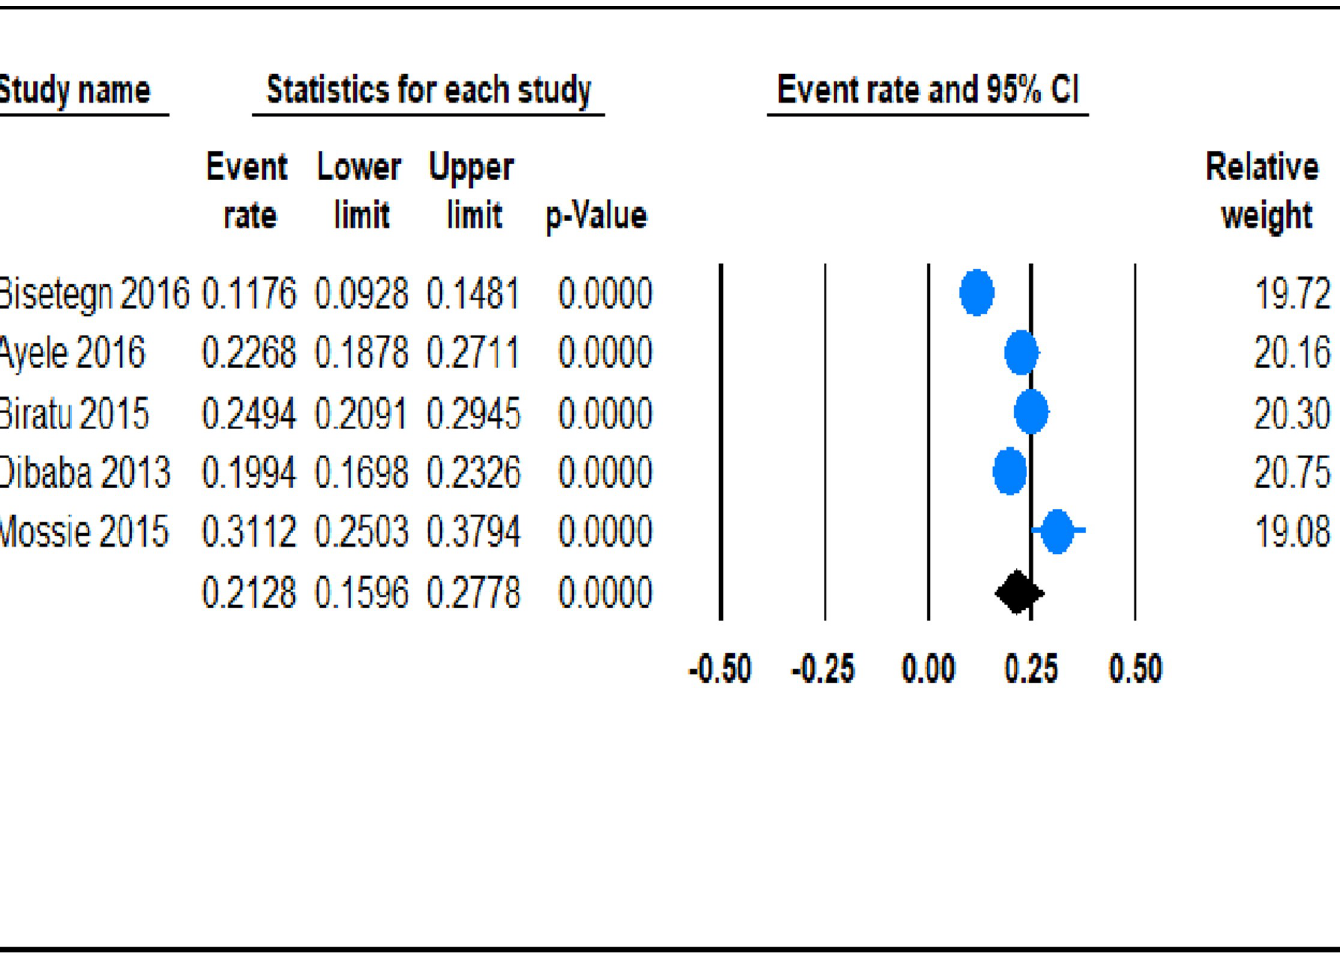
Fig 2. The prevalence of AND in Ethiopia: a